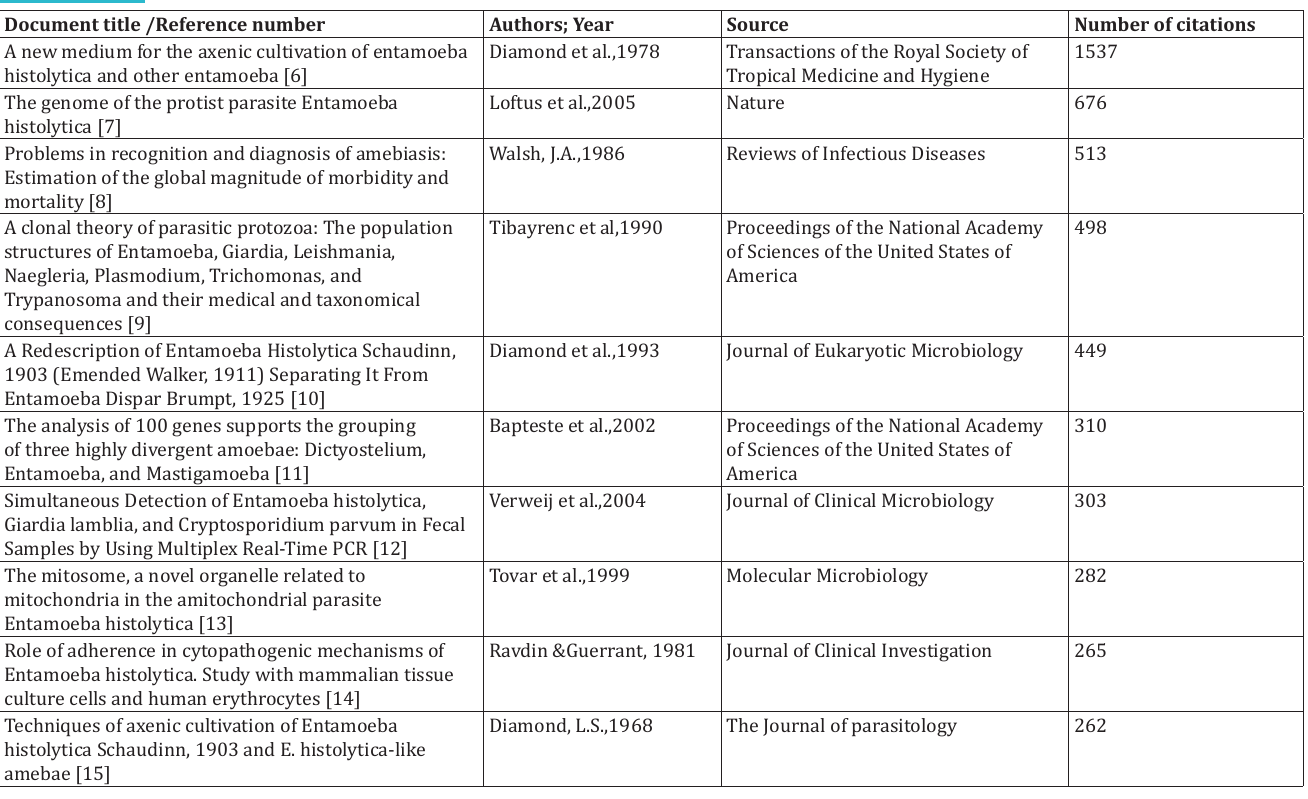
(n=451), National Institutes of Health (n=316), Consejo Nacional de Ciencia y Tecnología (n=243), U.S. Department of Health and Human Services (n=159), Japan Society for the Promotion of Sciences (n=451) were the top funding sponsors.